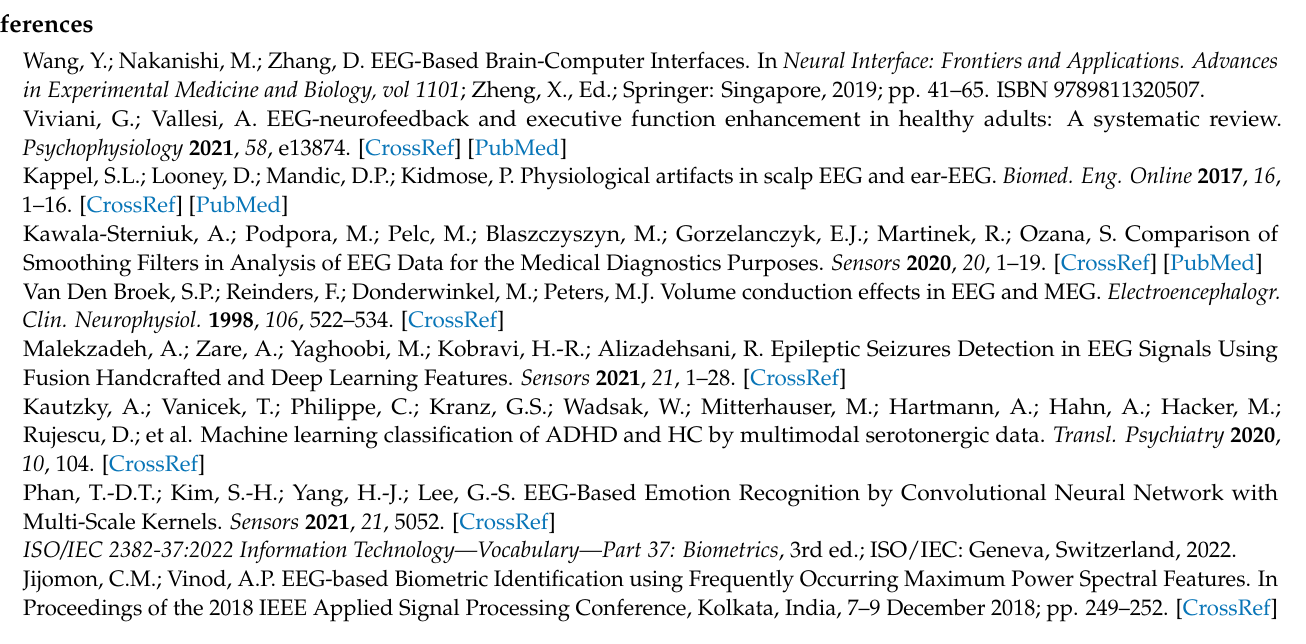
Figure A4. Network classification measures for selected combinations of many frequency bands, where the training and testing feature set vectors were separated by different parts of the same sessions ( left , the first scenario) and different sessions ( right , the second scenario).